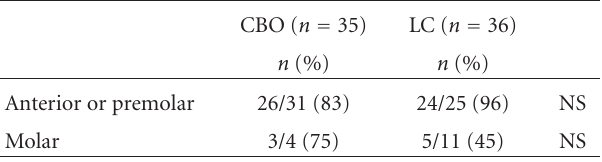
Table 4: Treatment success of anterior and premolar or molar